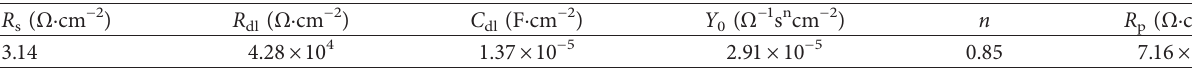
Figure 7: The equivalent circuit used to evaluate the EIS data presented in Figure 8. Table 2: Fitting results of the equivalent circuit obtained by fitting the EIS data.